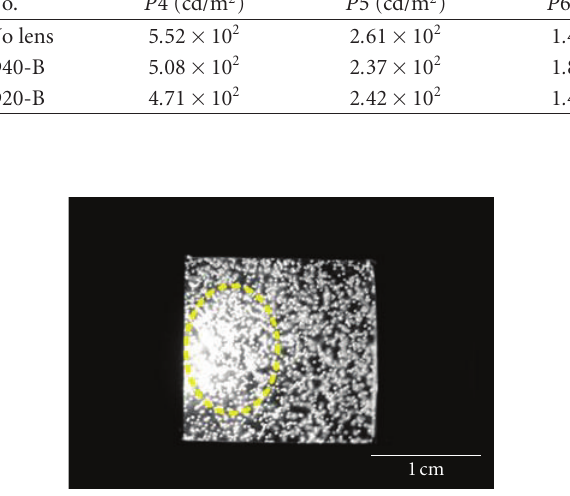
Figure 21: Embedded microvoids optical film with no structure.